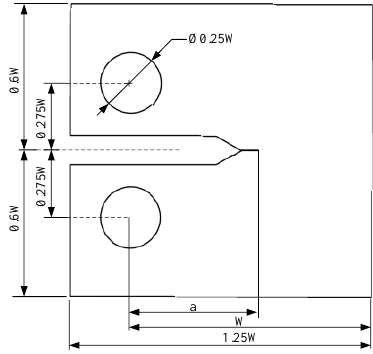
Figure 1. 1T-CT specimen geometry (where W = 50 mm, a = 0.5 W, B is specimen thickness B = 0.5 W).